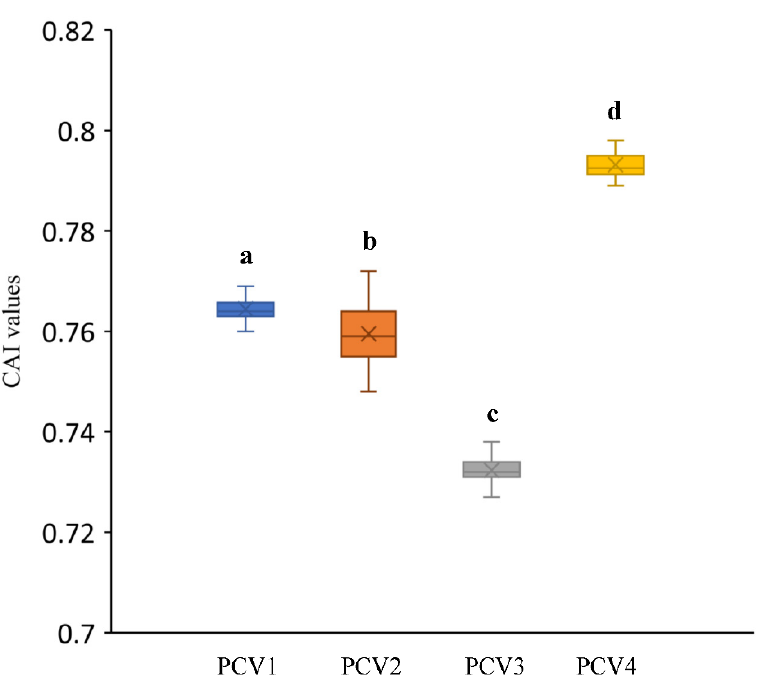
Figure 5. CAI values for each PCVs species. Different low ‐ case letters represented statistically sig ‐ nificant differences among different PCVs genotypes. significant differences among different PCVs